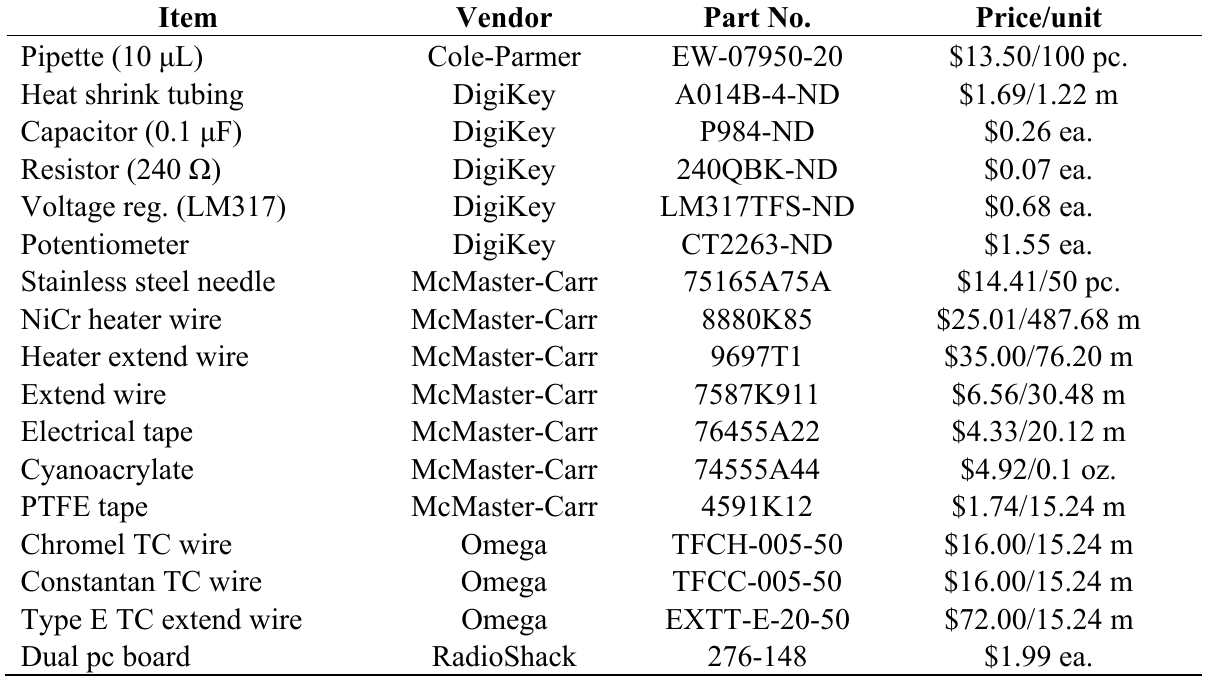
Table 2. Commercial vendor 2011 part numbers and pricing for sap flow probe and voltage regulator